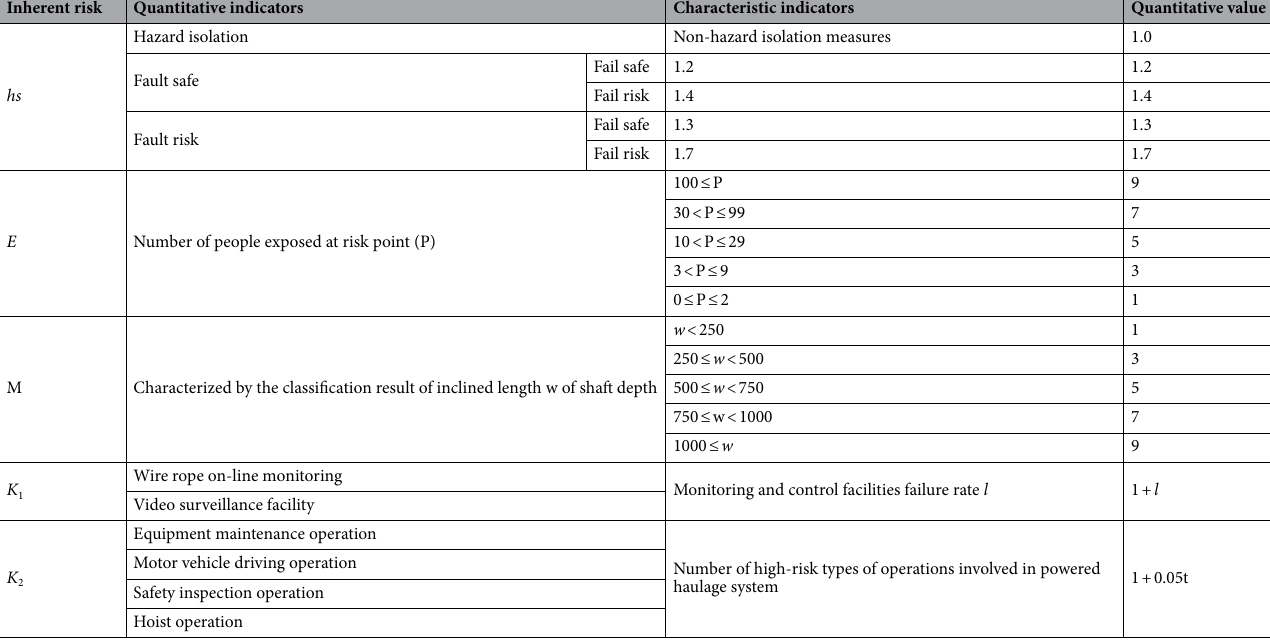
Table 2. Powered haulage accident risk point.